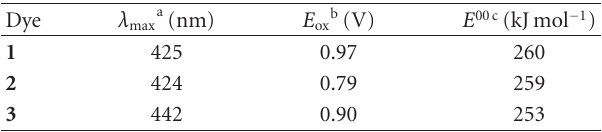
Table 1: Photophysical and electrochemical properties of studied